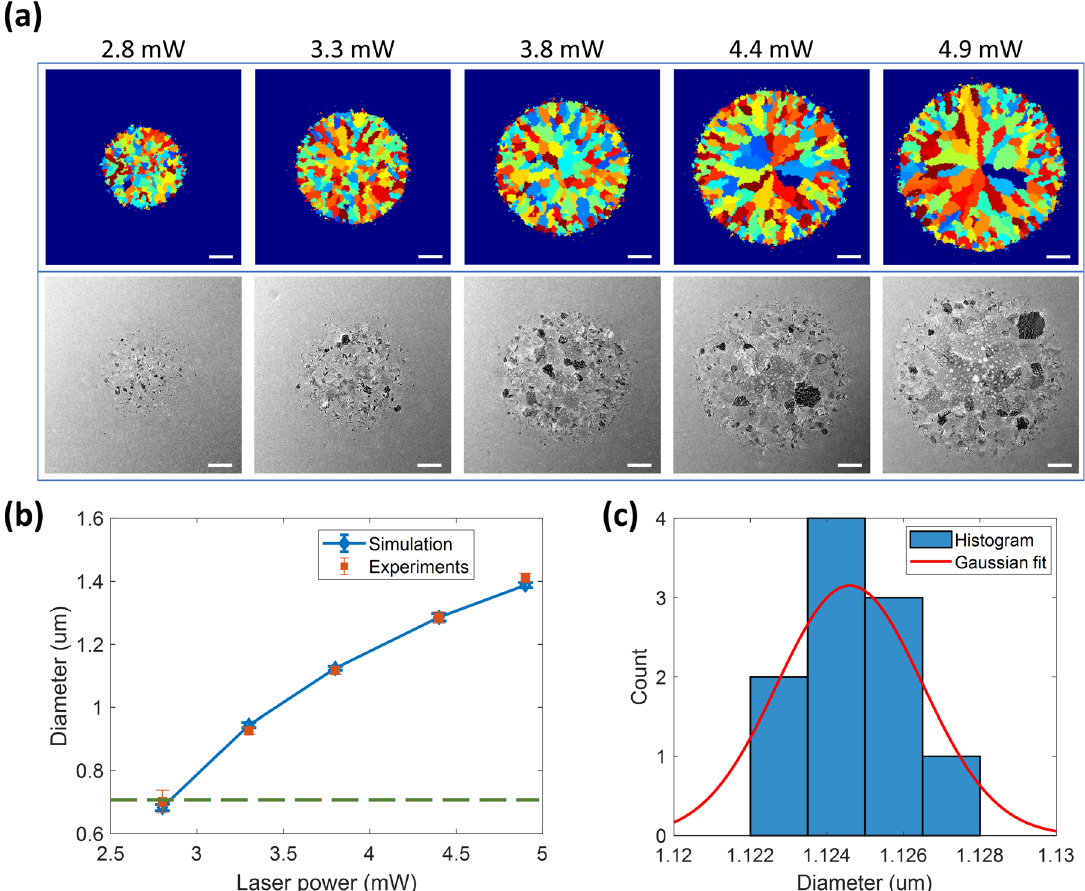
Fig. 4 Crystallographic microstructures. a Crystallographic microstructures at different laser power. First row: simulation; Second row: experiments. The scale bar is 200 nm. b Mean diameters of crystallised regions at different laser powers. The dashed green line indicates the FWHM of the laser beam. c Histogram of the crystallised mark diameters, which was simulated for an incident laser power of 3.8